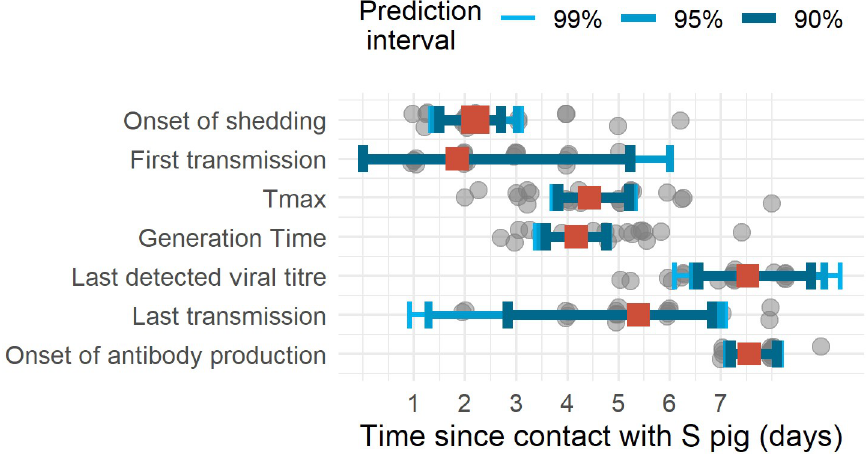
Fig 7. Natural history parameters. Grey dots represent the observed values, red square represent the average simulated replicates mean and the blue intervals, 90%, 95% and 99% prediction intervals computed from 100 replicates of 11 pigs